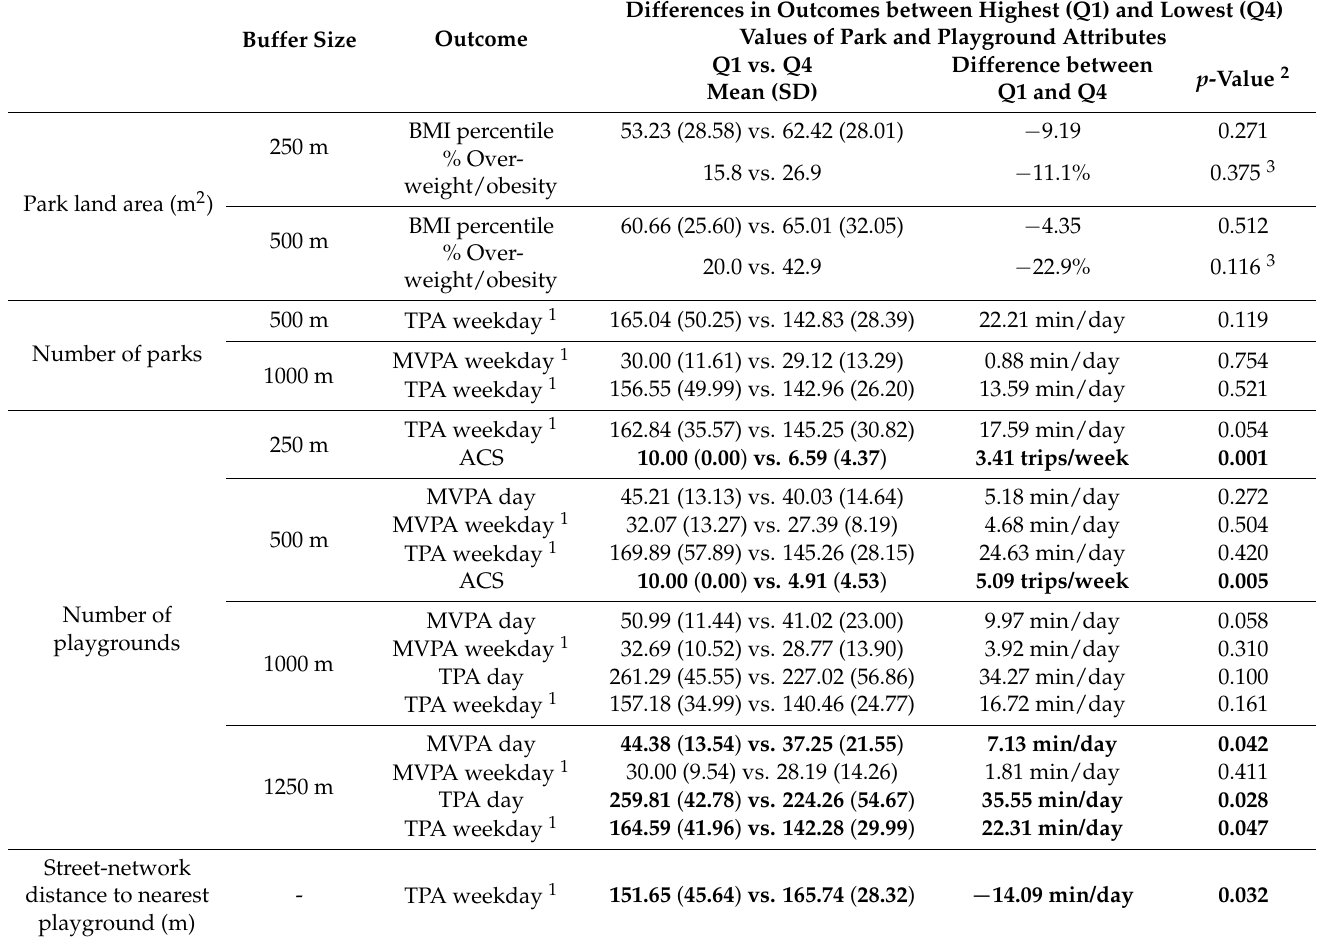
Table 6. Differences in outcomes between participants with high (Q1) and low values (Q4) for significant park and playground